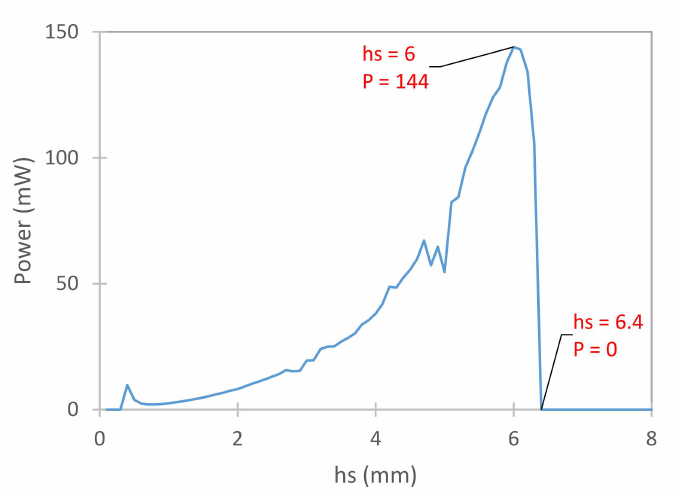
Figure 13. Graph Showing Variation of Power Output with Substrate Layer Thickness h s